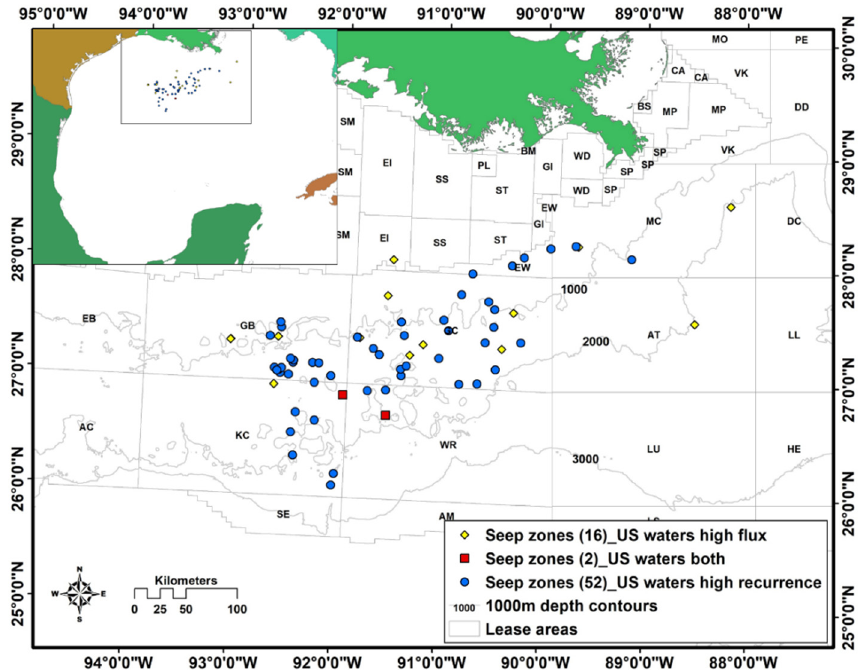
Figure 12. Distribution of seep flux and recurrence rates exhibited by the subset of more oily and more active seep zones. The light gray dashed lines indicate rates that are ±1 SD and the dark gray dashed lines indicate rates that are +2 SD.